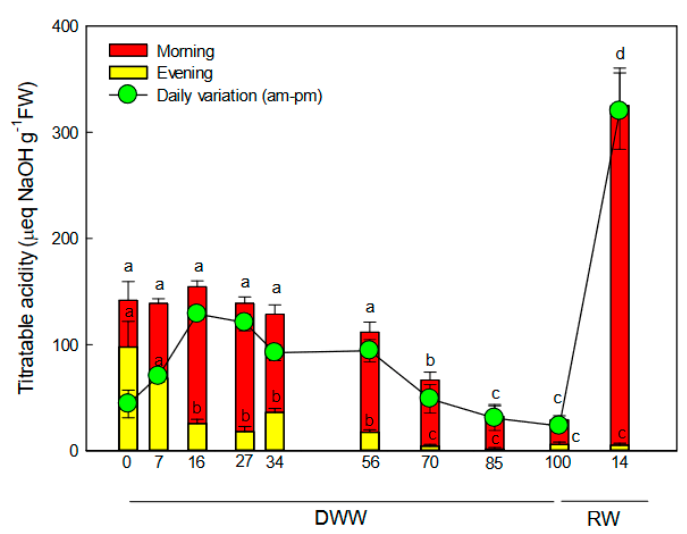
Figure 1. Trend of daily acid fluctuation during days without water (DWW) and rewatering (RW). Different letters indicate statistically significant differences in morning or evening acid content ( p ≤ 0.05). Data were analyzed by one-way ANOVA repeated measurements followed by the Tukey’s test. Data are means ( n = 10) ± SE.